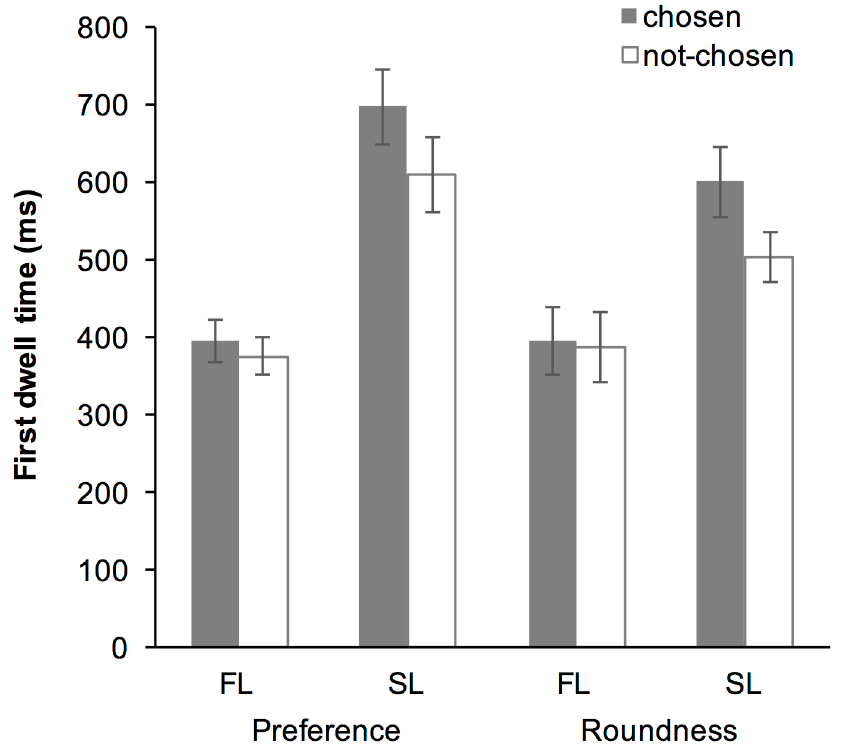
Fig 4. Averaged first dwell time in Experiment 1. Error bars represent standarderror of the mean.